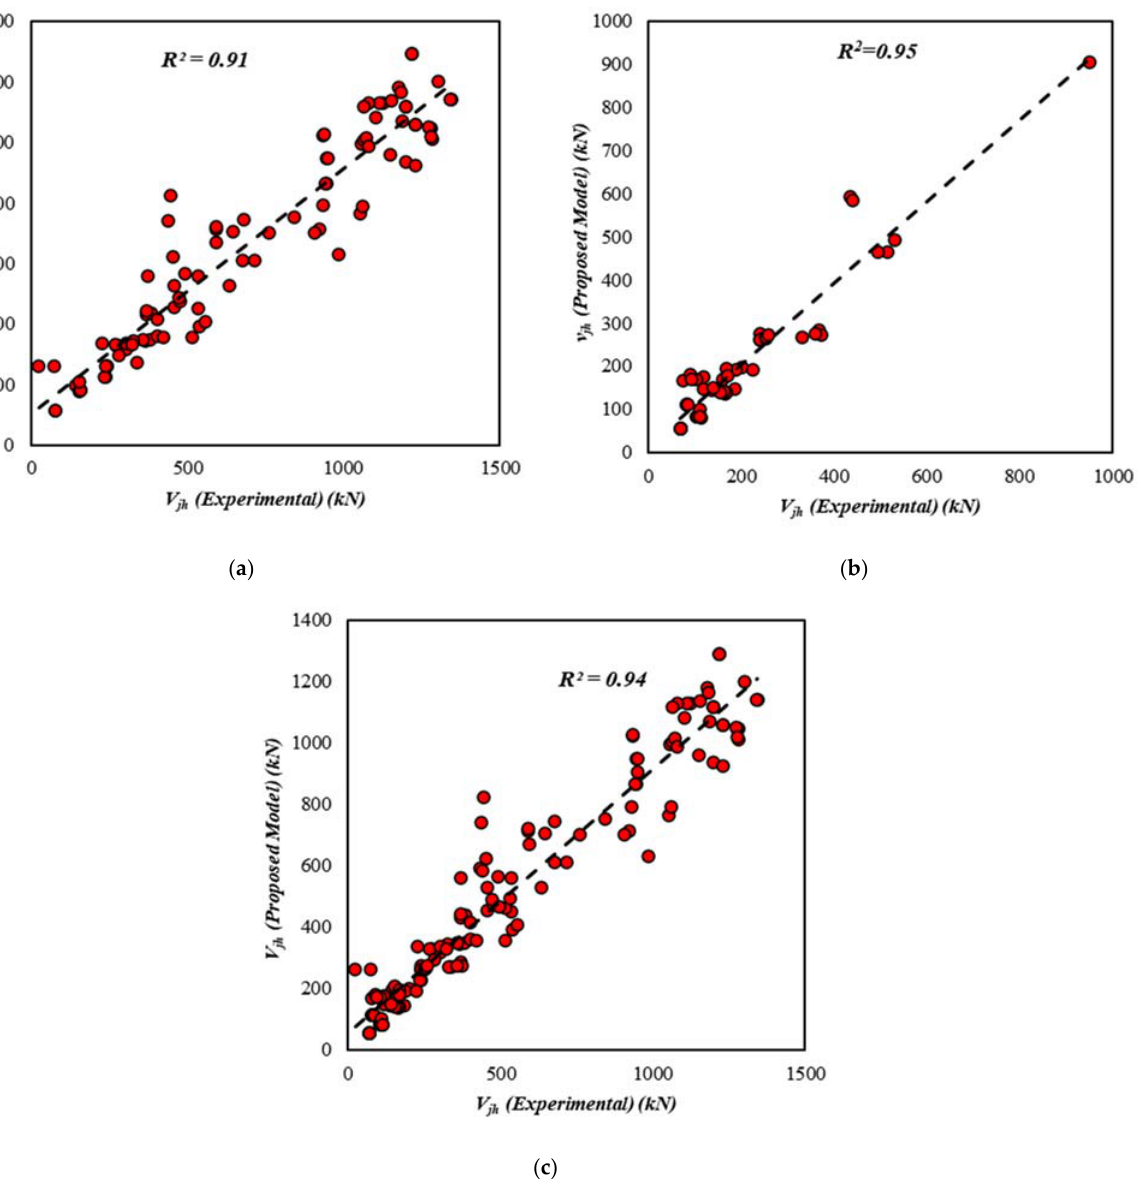
Figure 6. Results for the shear strength of the reinforced interior joints ( a ) training data, ( b ) validation data, ( c ) all data.